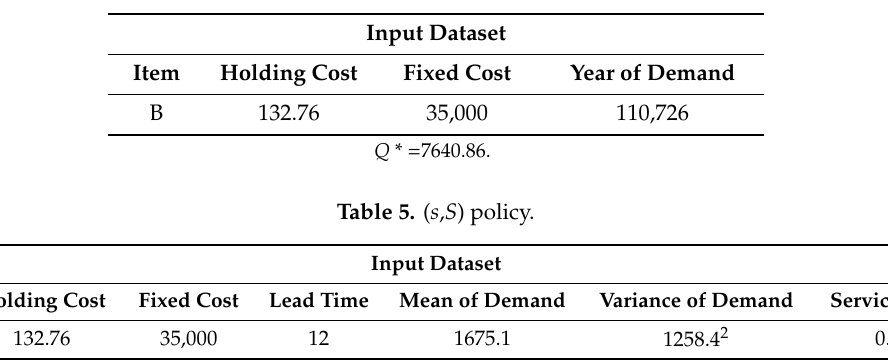
Table 4. Economic order quantity (EOQ) model.